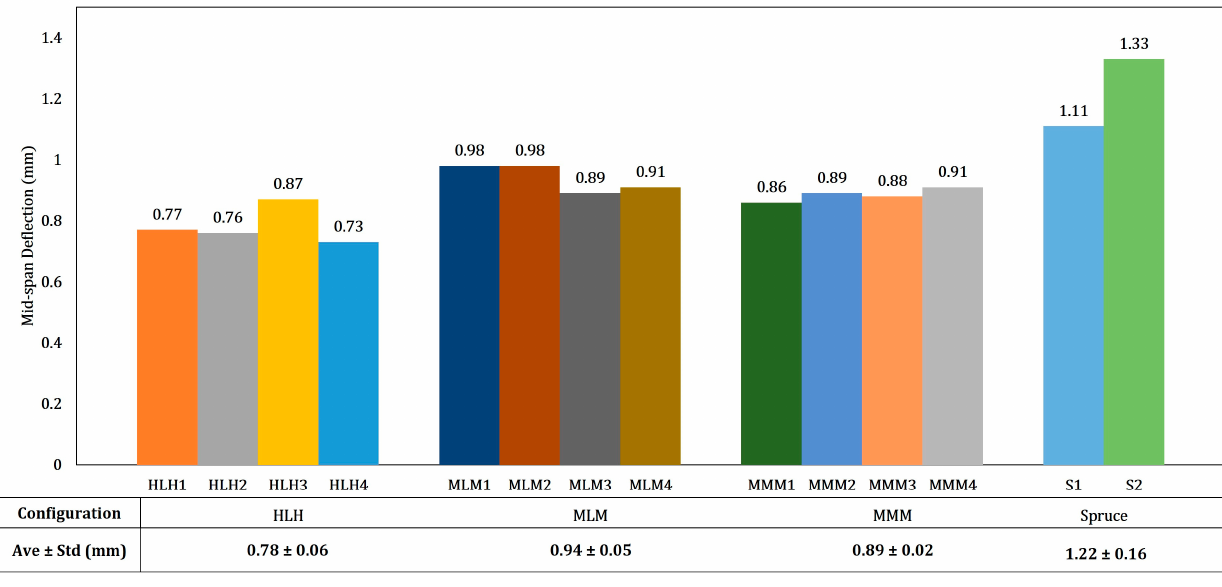
Table 5. Comparisons of the experimental and theoretical results. Configuration